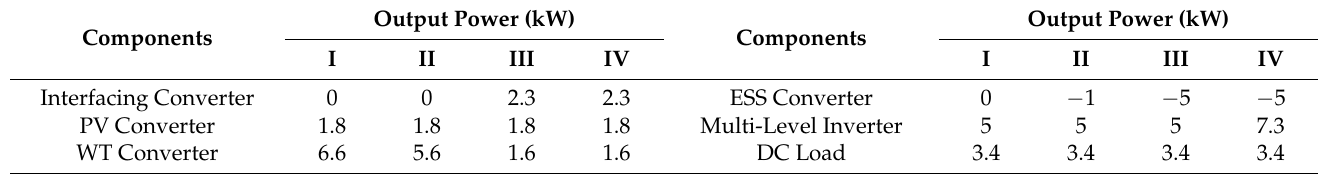
Figure 29. Experiment waveforms of PV converter and ESS converter in mode 5. Table 5. Output power of each power conversion devices in mode 5.